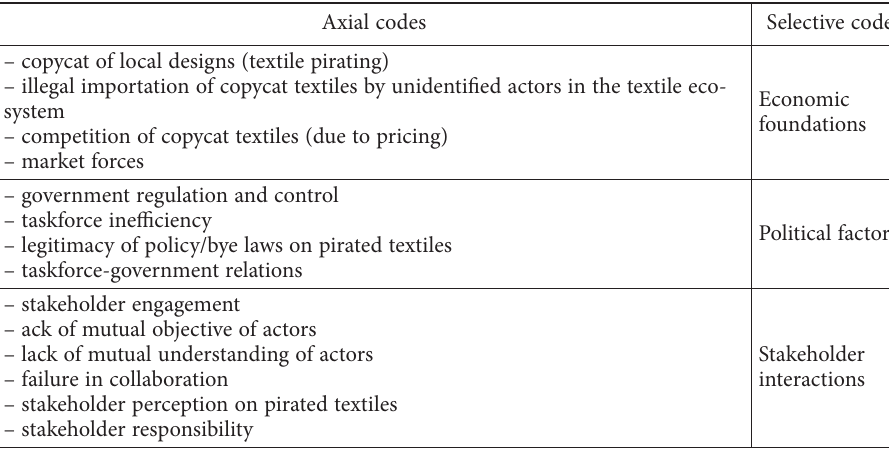
Table 4. Axial and selective codes (source: prepared by